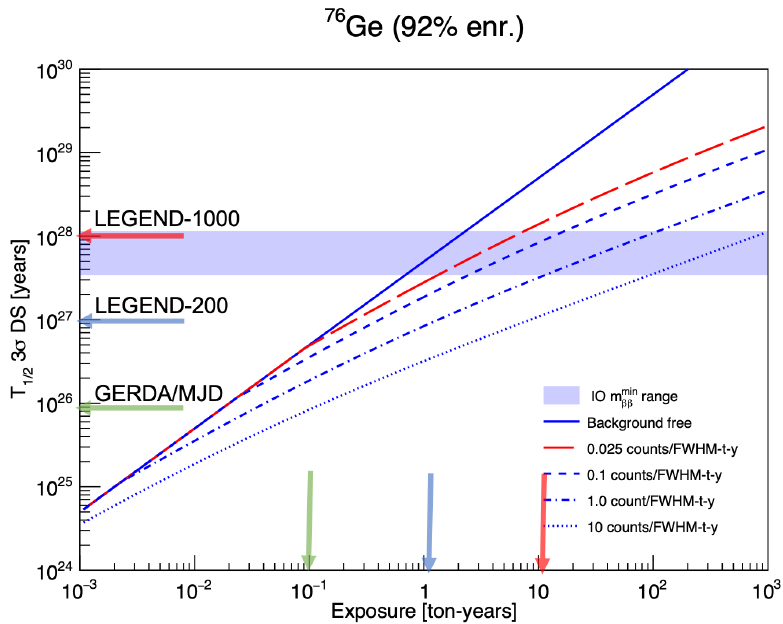
Figure 28. 0 νββ decay half-life 3 σ discovery potential as a function of exposure and background rate.